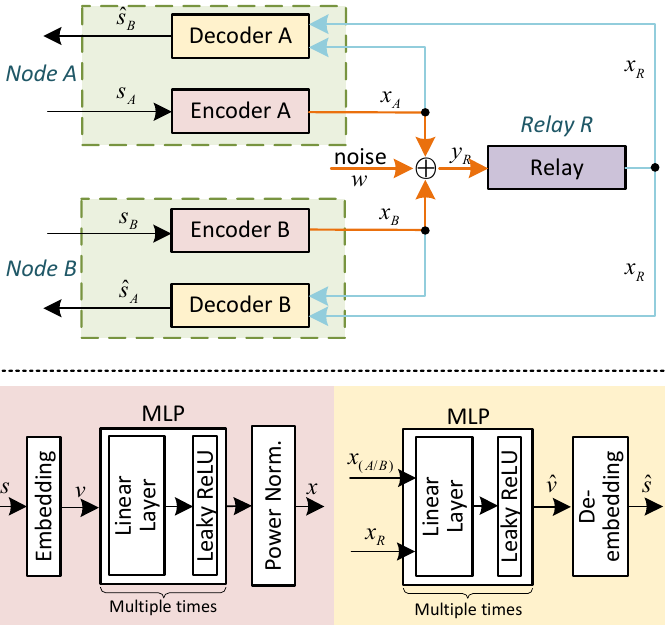
Figure 2. DNN-based PNC scheme. A pair of encoder and decoder refers to the modulation module and demodulation module of the same node. We use the same color as in Figure 1 to show the uplink and downlink